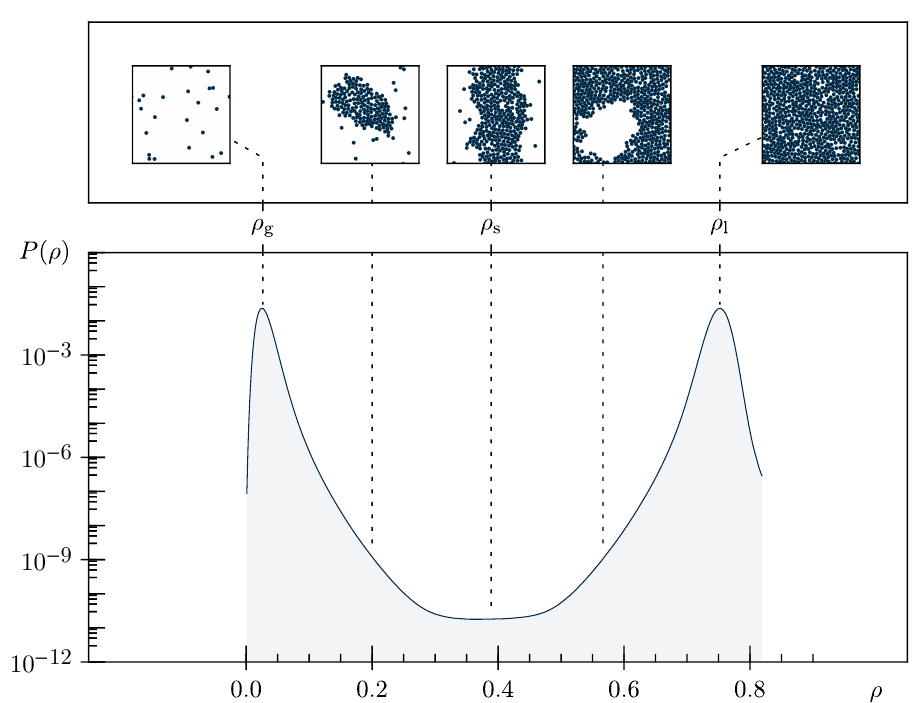
Figure 2: Grand canonical probability distribution of a system with linear size L = 30 at temperature T = 0.4 and equal-height chemical potential µ ≈ − 1.6518. Matching snapshots are shown on top and the whole density region over which the gas-liquid transition takes place is covered. P ( ρ ) shows peaks at the densities corresponding to the gas ( ρ ) and the liquid ( ρ ). In between appears a suppressed plateau around g l the density where a stripe occurs ( ρ s